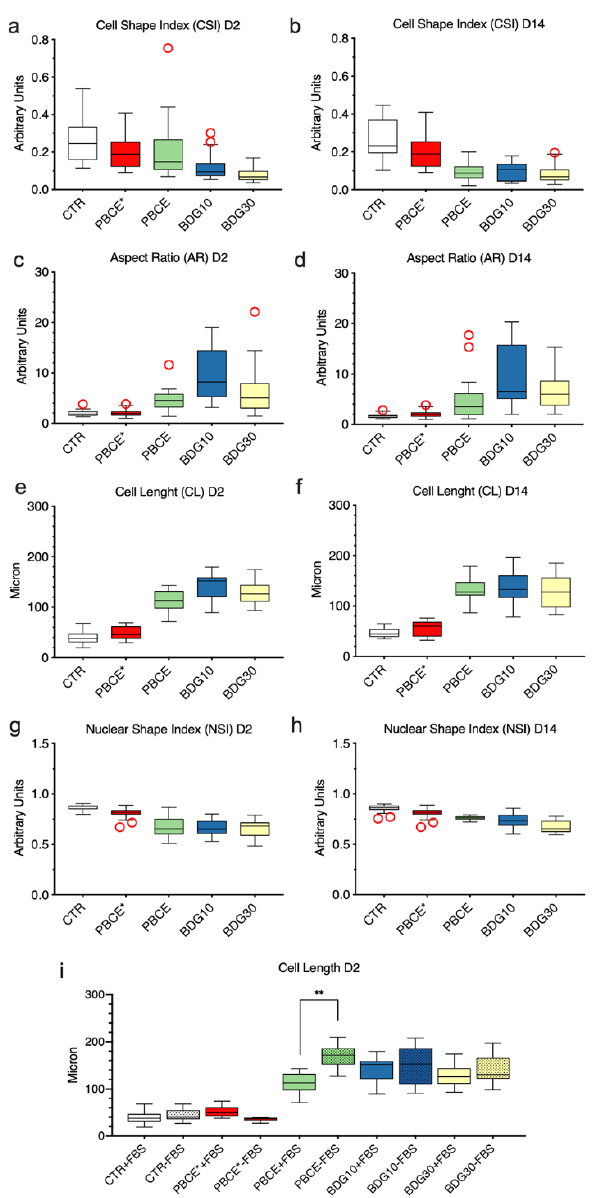
Figure 3. Quantitative morphometric measures of hBM-MSCs on polymer films. Measurements were carried out as described in the methods section at D2 and at D14. ( a , b ) cell shape index (CSI); ( c , d ) aspect ratio (AR); ( e , f ) cell length (CL); ( g , h ) nuclear shape index (NSI). ( i ) Comparison of the cell length (CL) between stem cells grown on film- and CTR-cultures on D2 in the presence ( + ) and absence ( − ) of FBS. Red circles: outliers. The results are expressed as the mean of three independent experiments, ** p < 0.01.